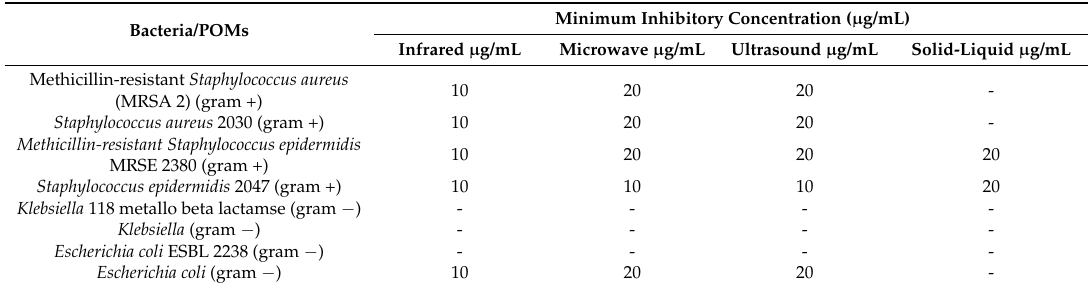
Table 1. Minimum inhibitory concentration ( µ g/mL) of different gram-positive and gram-negative bacteria obtained with different extraction techniques. (-) indicates the absence of inhibitory effects.